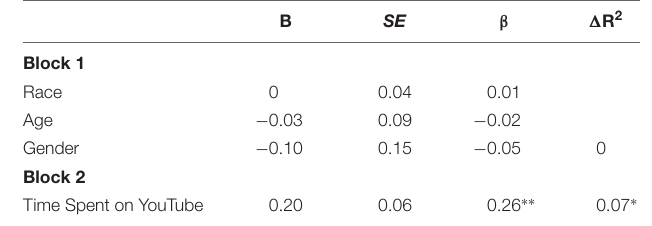
TABLE 2 | Summary of hierarchical regression for time spent on YouTube predicting wishful identification.